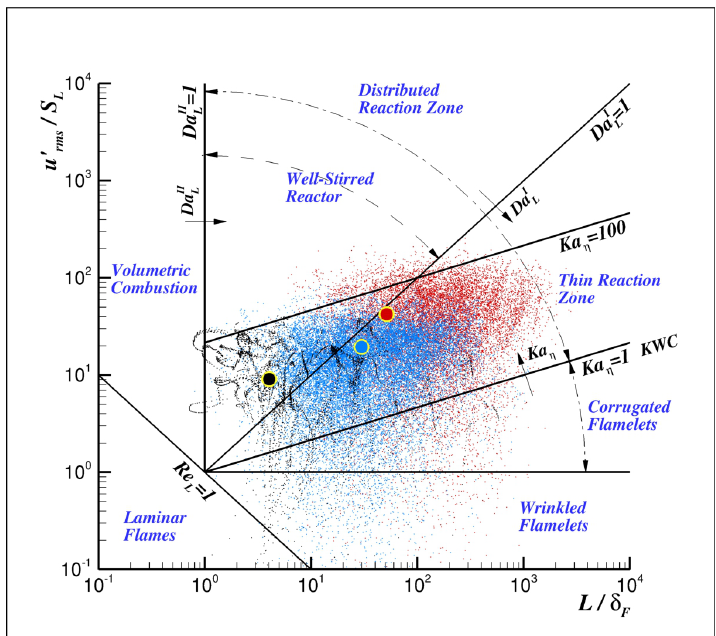
Figure 1. Actual combustion regimes and their global state (yellow marked) experienced in three CH 4 /H 2 /Air (50/50 by volume) premixed flames at 1 (black dots), 10 (blue dots), and 40 (red dots) bar